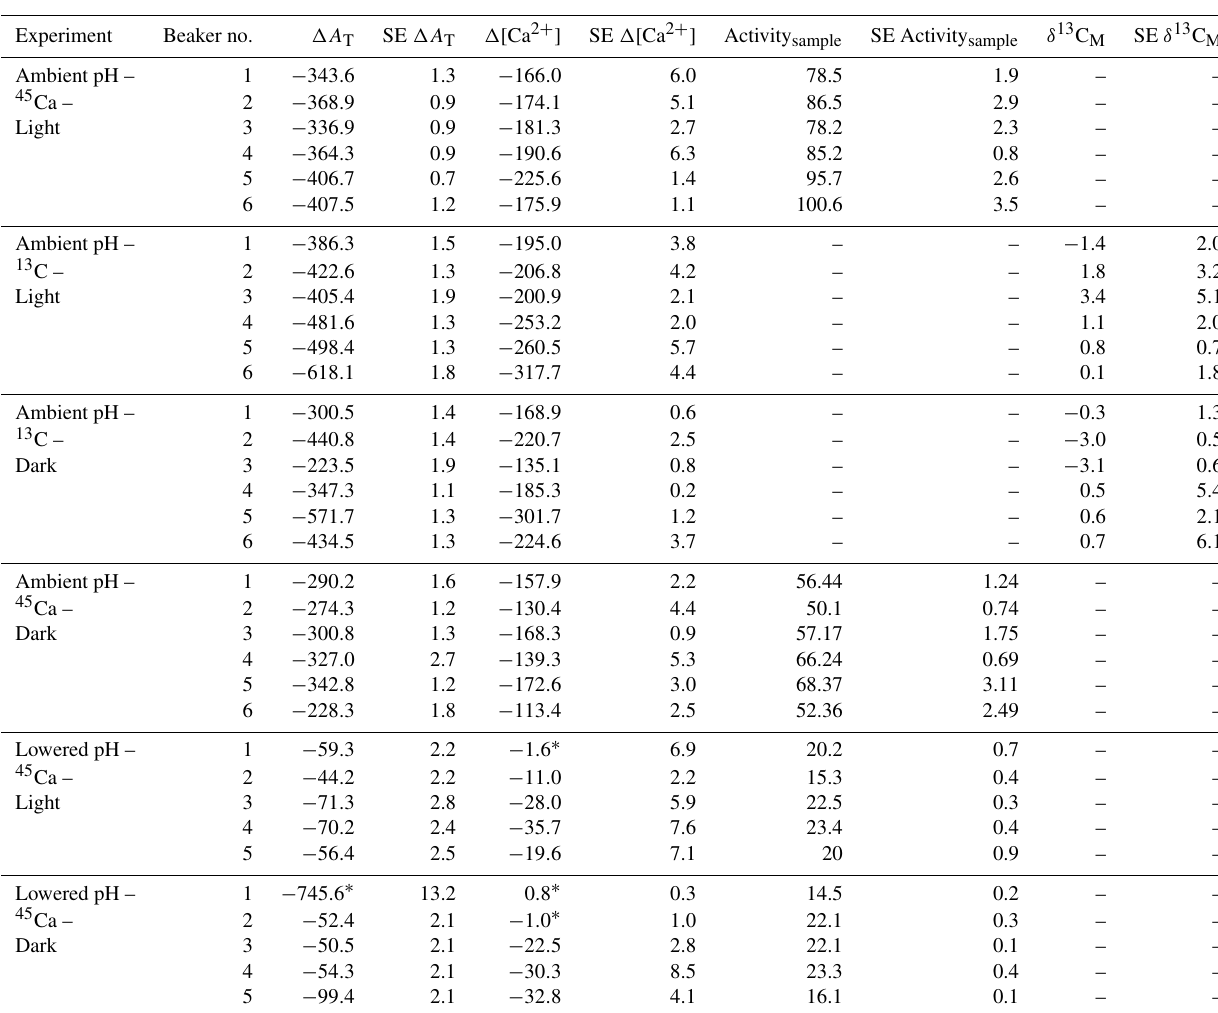
Table 3. Changes in total alkalinity ( A T ) and calcium concentrations ([Ca 2 + ]) during the different types of incubations compared to control beakers: (cid:49)A T = A T2 − A T2c , (cid:49) [ Ca 2 + ] = Ca 2 − Ca 2c , both expressed in micromoles per kilogram. Standard errors (SE) have been calculated (cid:113) (cid:113) + SE 2 + SE 2 as SE 2 and SE 2 for A T and [Ca 2 + ], respectively, where SE corresponds to standard errors associated with the A T2 A T2c Ca 2 Ca 2c measurement of three analytical replicates per sample. 45 Ca activity (Activity sample , Bq) and 13 C incorporation ( δ 13 C M , ‰) of sampled corals are also shown. Values of 45 Ca activity and δ 13 C are mean ± standard error of the mean (SE) associated with the measurement of three aliquots for each coral. Outliers ( n = 4; see text for details) are identified with an asterisk.